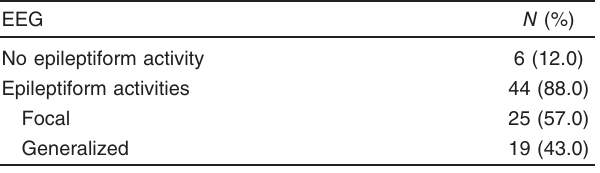
generalized) according to electroencephalographic results